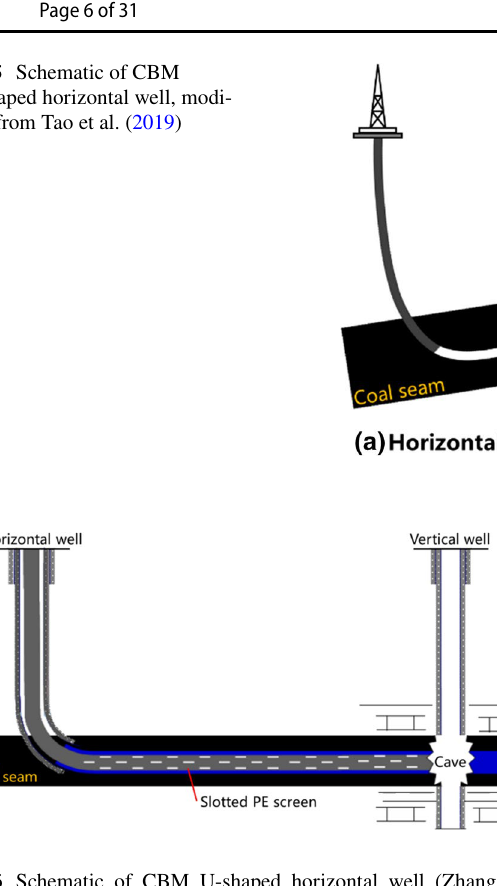
Fig. 7 Schematic of CBM V-shaped horizontal well, modified from Flores